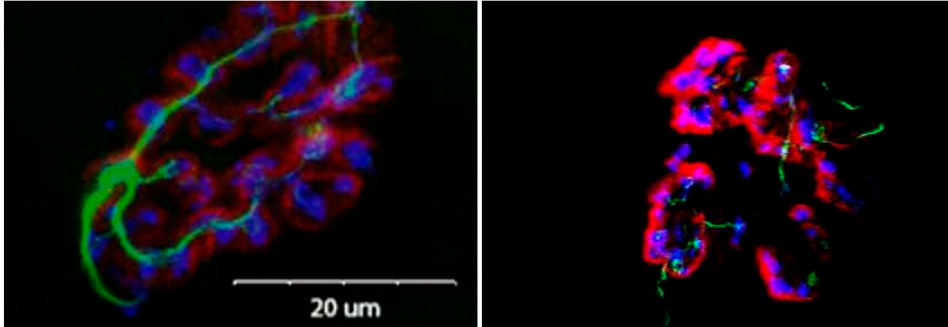
Figure 3. Micrograph showing close coupling of presynaptic vesicles and terminal branches with postsynaptic receptors. Presynaptic terminal branches are stained green, presynaptic vesicles are stained blue and postsynaptic receptors are stained red. Note the greater complexity of nerve terminal branching in aged NMJ.